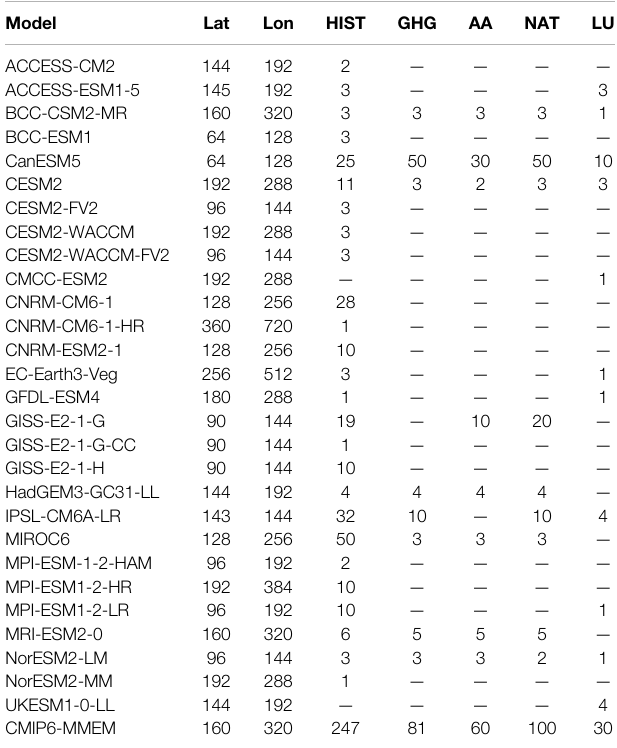
TABLE 2 | Same as Table 1 , but for mrsol (total water content of the soil layer).